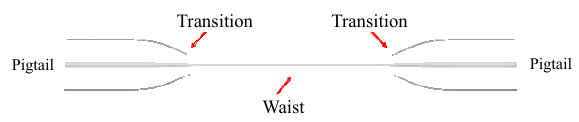
Fig. 1 Typical microfiber structure fabricated from standard optical fiber using the heat-and-pull